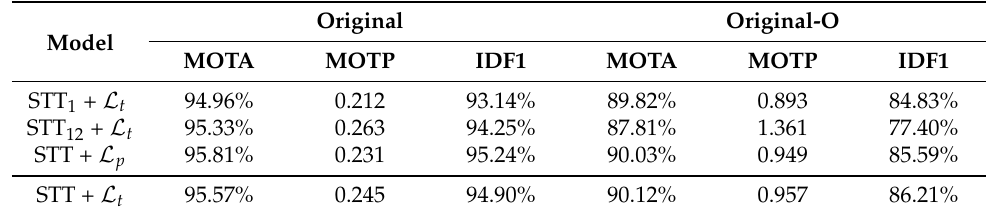
Table 4. Ablation experiments on individual components of